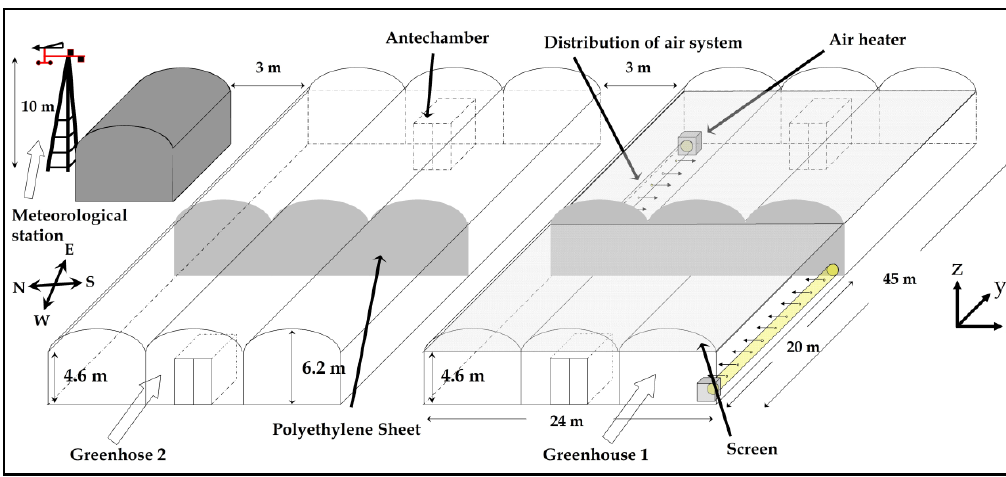
Figure 1. Location of the experimental greenhouse at the